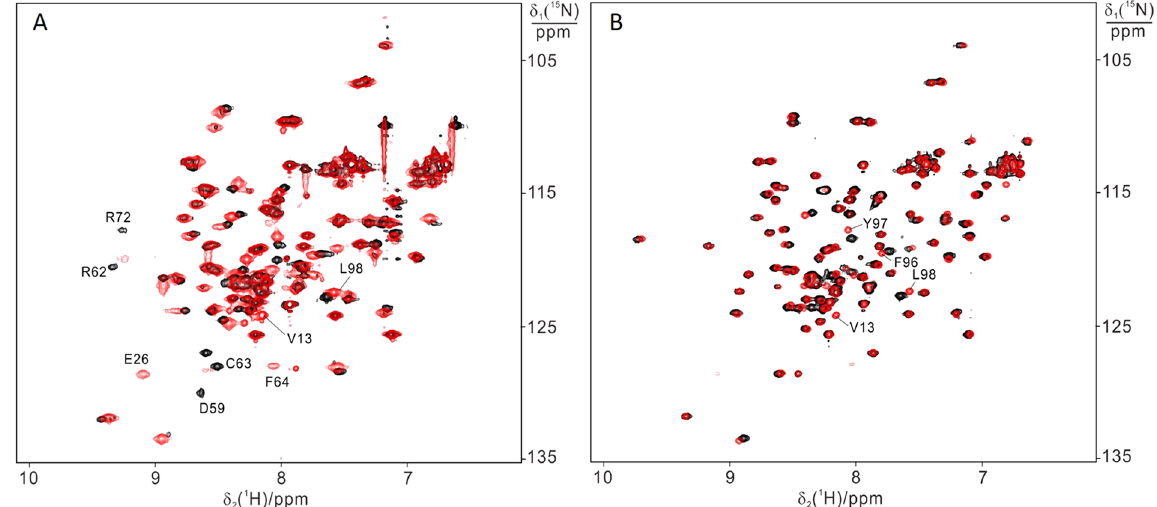
Figure 8. 15 N-HSQC spectra recorded for the solution of 0.2 mM protein in the absence (red) and presence (black) of 0.1 mM copper sulfate. ( A ) 0.2 mM WT BIR1; ( B ) 0.2 mM D71N/R72E. NMR spectra were recorded in 20 mM Bis-Tris, at pH 6.5 and at 298 K, with a proton frequency of 600